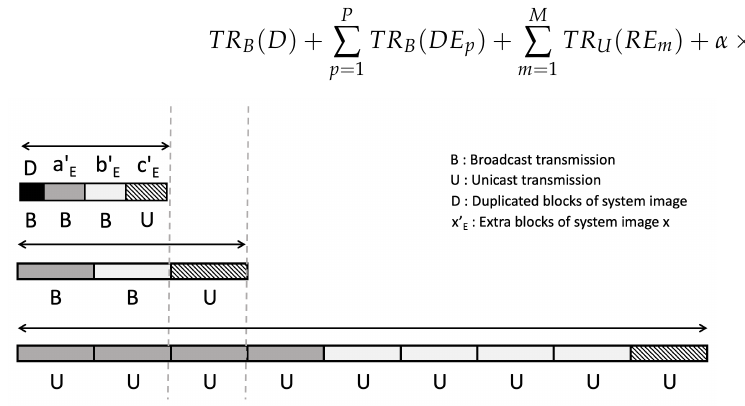
Figure 9. Comparison of the amount of data transmitted in three different